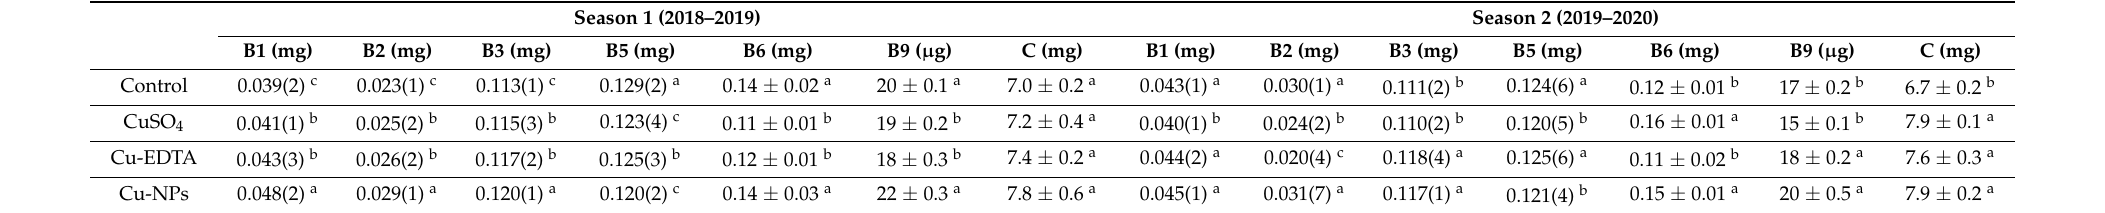
Each value represents the mean ± standard error. Values with different letters show significant differences at p ≤ 0.05 (Duncan’s